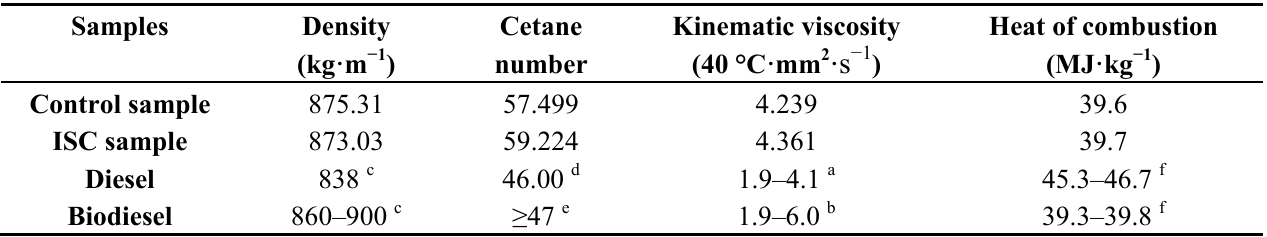
Table 5. Density, cetane number and kinematic viscosity for C. vulgaris , diesel and